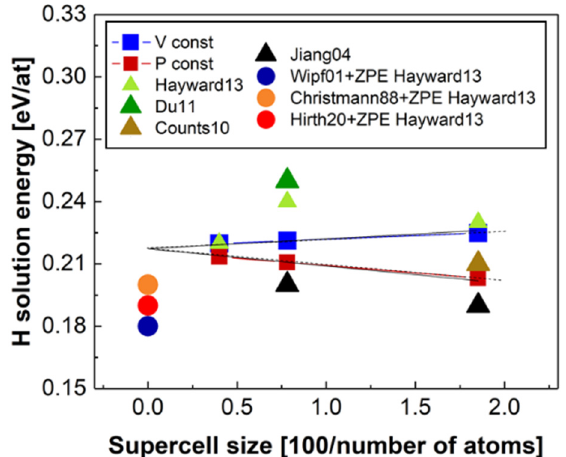
Figure 5. Dependence of the TS-H-interstitial formation energy on the supercell size at constant volume (blue line, blue squares) and at constant pressure (red line, red squares). The results of the present calculations are compared to other theoretical [62,78,107,113] data marked as triangles and experimental data extrapolated to 0 K (ZPE corrected) [110–112] and marked as circles.